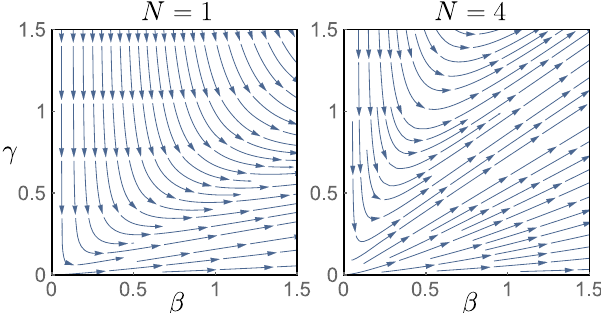
FIG. 6. The RG flow of the dimensionless phonon-phonon coupling γ and the dimensionless electron-phonon coupling β corresponding to Eqs. (17) and (21) in the limit ζ T ¼ 0 . The left represents the case of a single fermionic flavor N ¼ 1 , and the right is for N ¼ 4 . The scale when γ reaches the order of 1 never exceeds Λ β